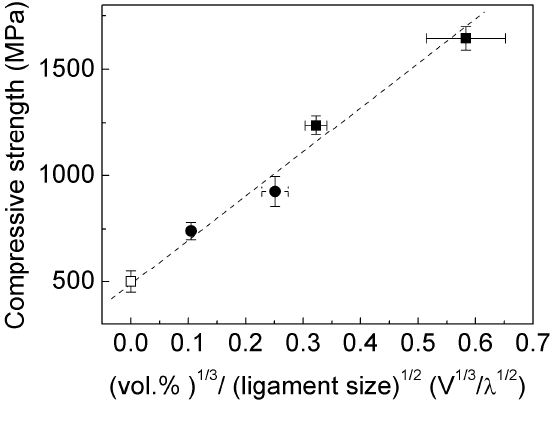
Figure 14. Compressive strength as a function of volume fraction and matrix ligament size − ∝ λσ V ) for: (  ) pure brass, (  ) blended and (  ) milled ( 2/13/1